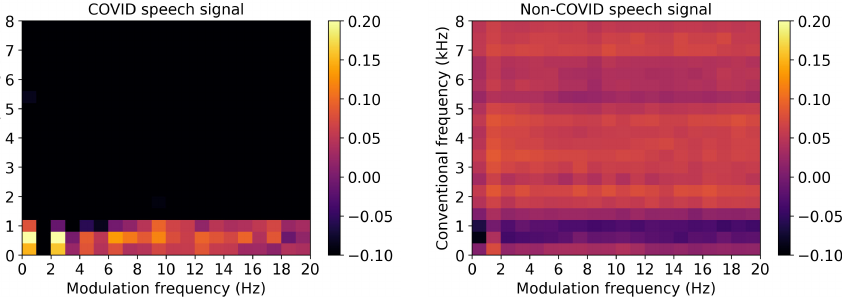
Figure 8. Normalized average modulation spectrograms for speech made by individuals with COVID-19 ( left ) and by healthy individuals ( right